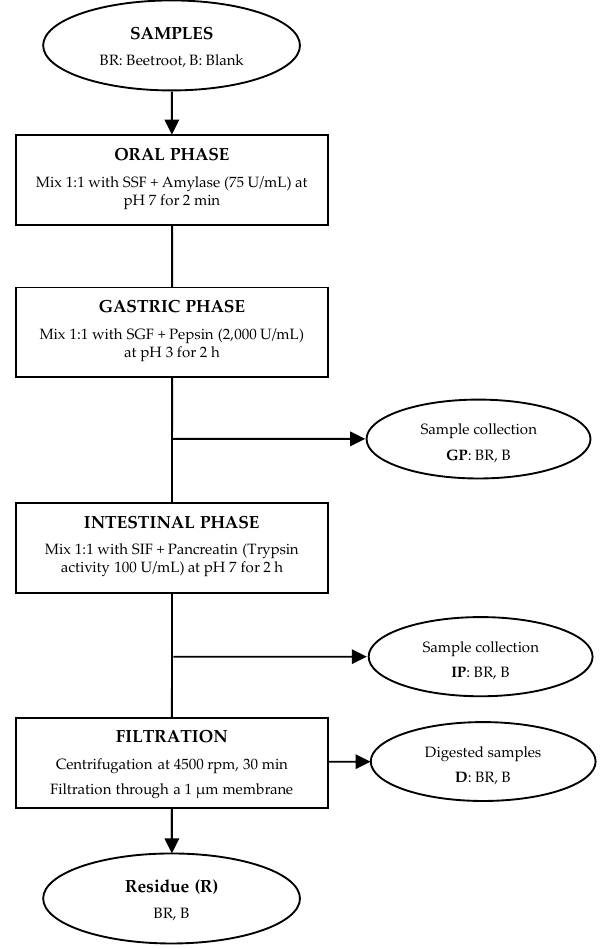
Figure 1. Flow diagram of the static in vitro model used for beetroot digestion. After mixing the beetroot sample with simulated salivary fluid (SSF) and amylase at pH 7 for 2 min, the oral bolus was mixed with simulated gastric fluid (SGF), pepsin, and gastric lipase at pH 3 for 2 h to obtain the gastric phase (GP). Then, the intestinal phase (IP) was obtained by mixing the gastric chime with simulated intestinal fluid (SIF) and pancreatin at pH 7 for 2 h. Finally, the mixture was centrifugated and filtered to obtain the digested (D) sample. More details are provided in Table S1.